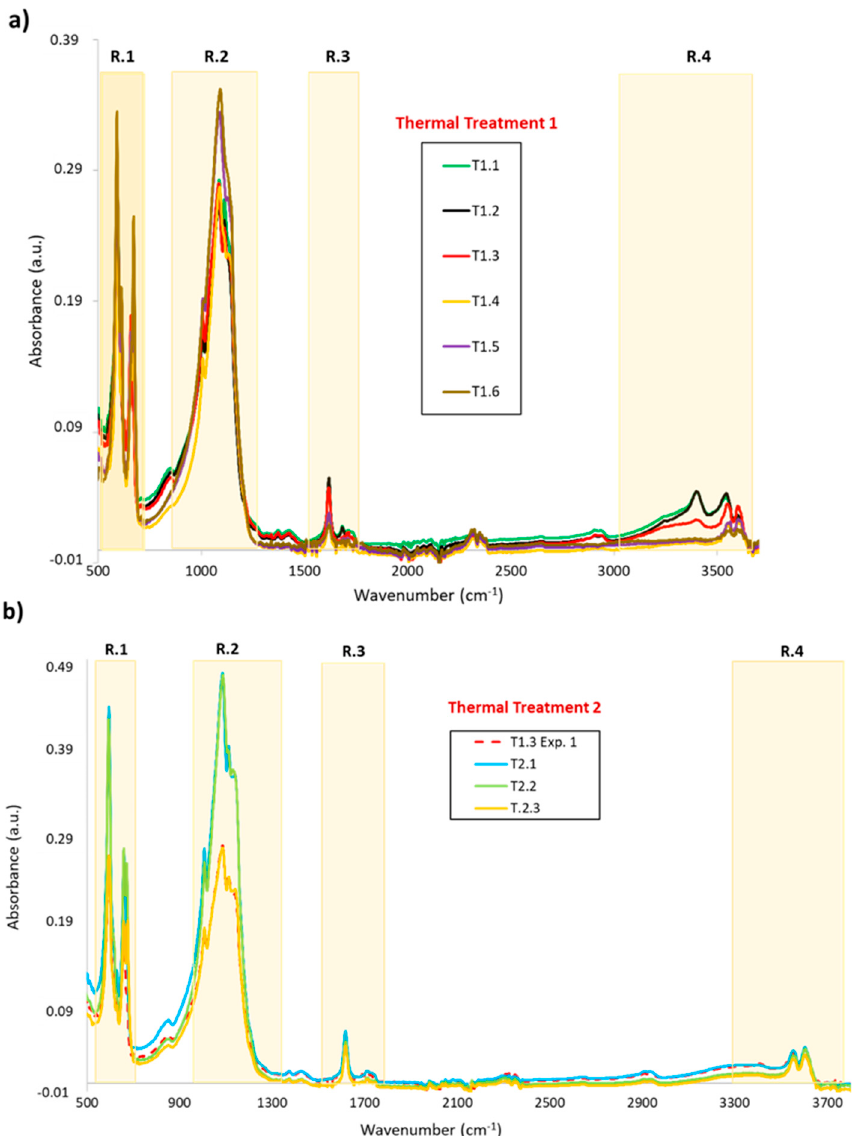
Figure 4. Infrared spectrum showing the four interesting regions for the different testing points for both thermal treatments: ( a ) Experiment 1 and ( b ) Experiment 2.